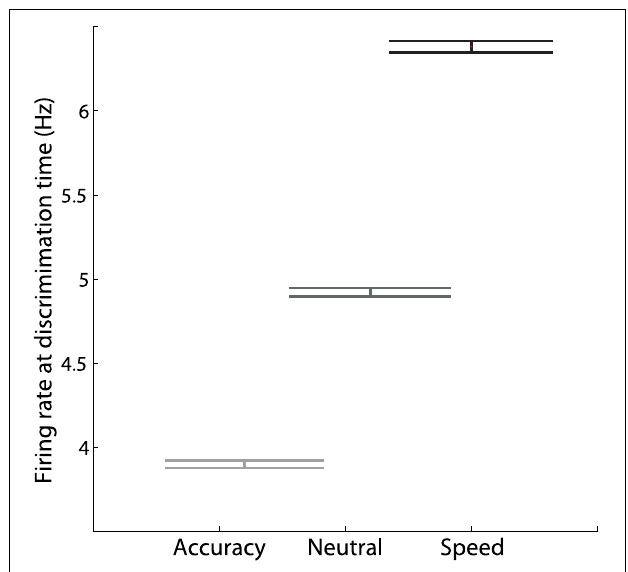
FIGURE 5 | The mean firing rate of the target population at the time at which an ideal observer can discriminate target activity from distractor activity, calculated across all positive coherence values. The rate is higher (lower) under speed (accuracy) conditions.